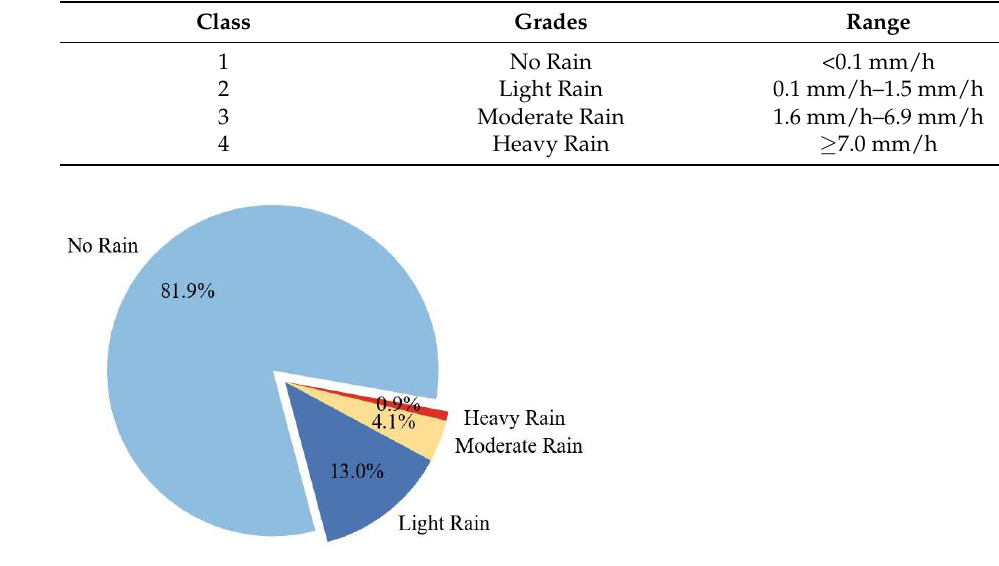
Figure 2. The proportion of all grades in the raw